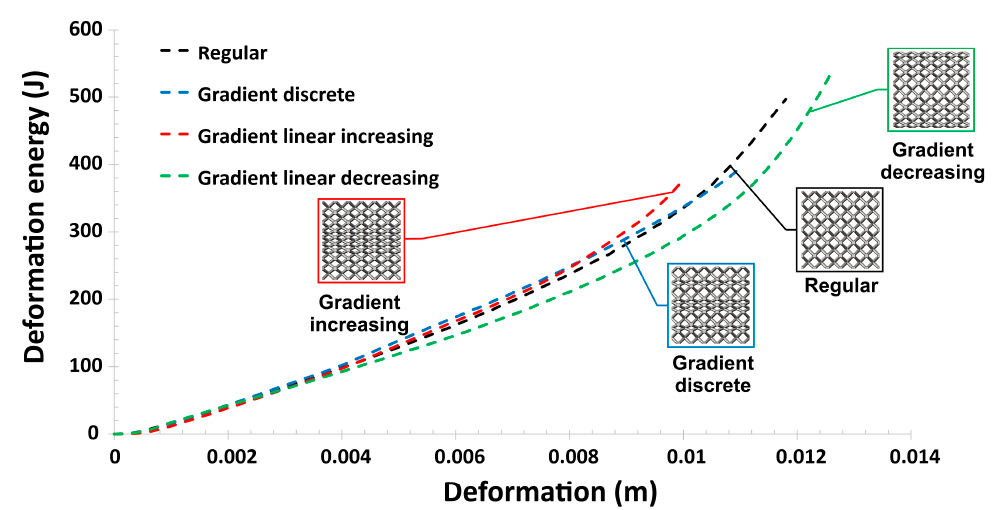
Figure 17. Results of compression tests (deformation energy versus displacement) conducted under impact loading